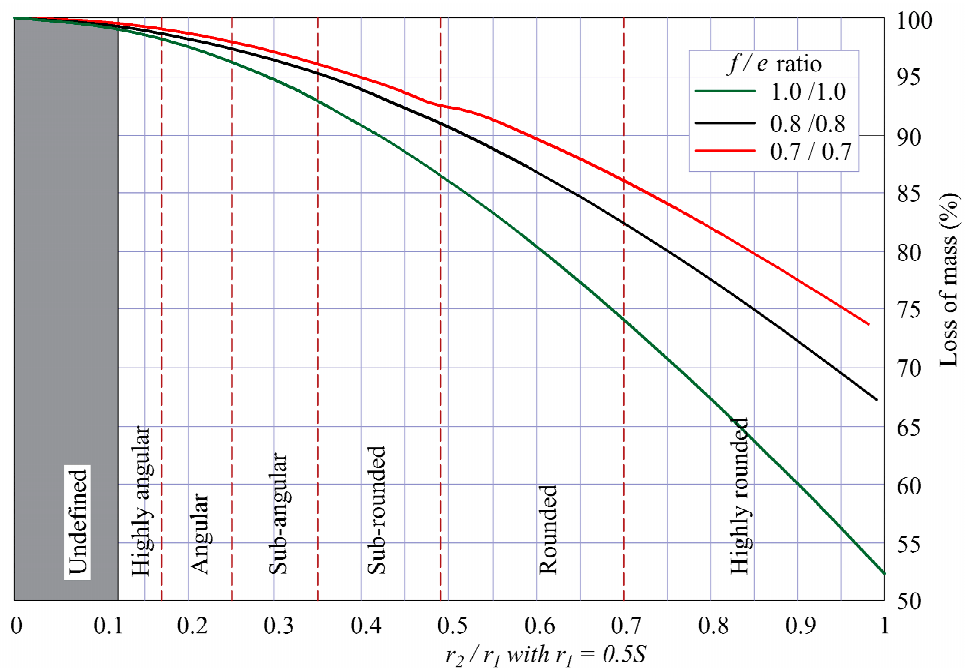
Figure 8. Relationship between mass loss and r 2 / r 1 of brick-shaped particles due to roundness for three ballast shape categories [66].